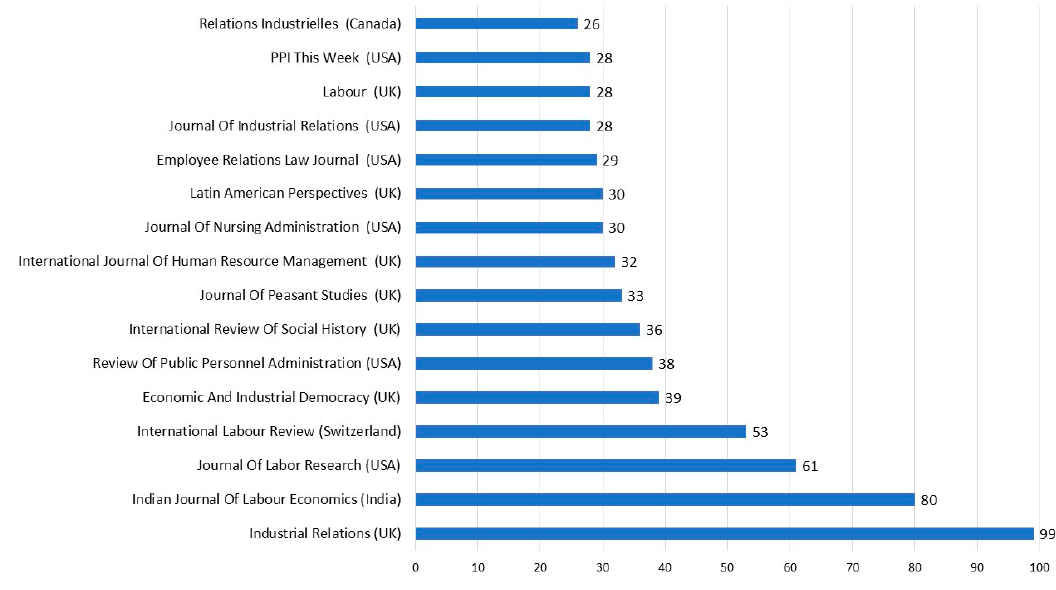
Figure 7. Main sources for labour relations worldwide research.